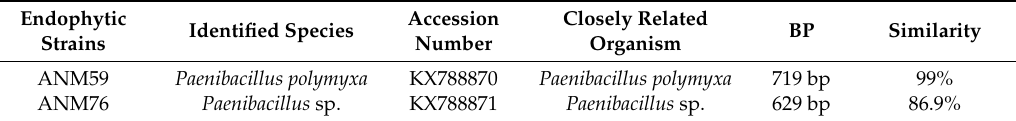
Table 5. Identification of endophytic strains ANM59 and ANM76 from chickpea by 16S rRNA partial gene